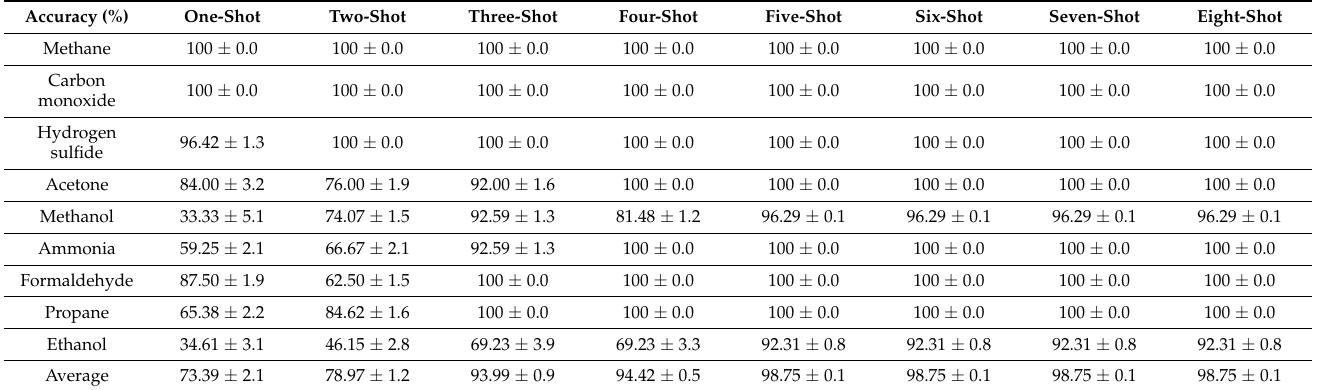
Table 3. The test accuracy for different gases based on the proposed SNN with different few-shot learning